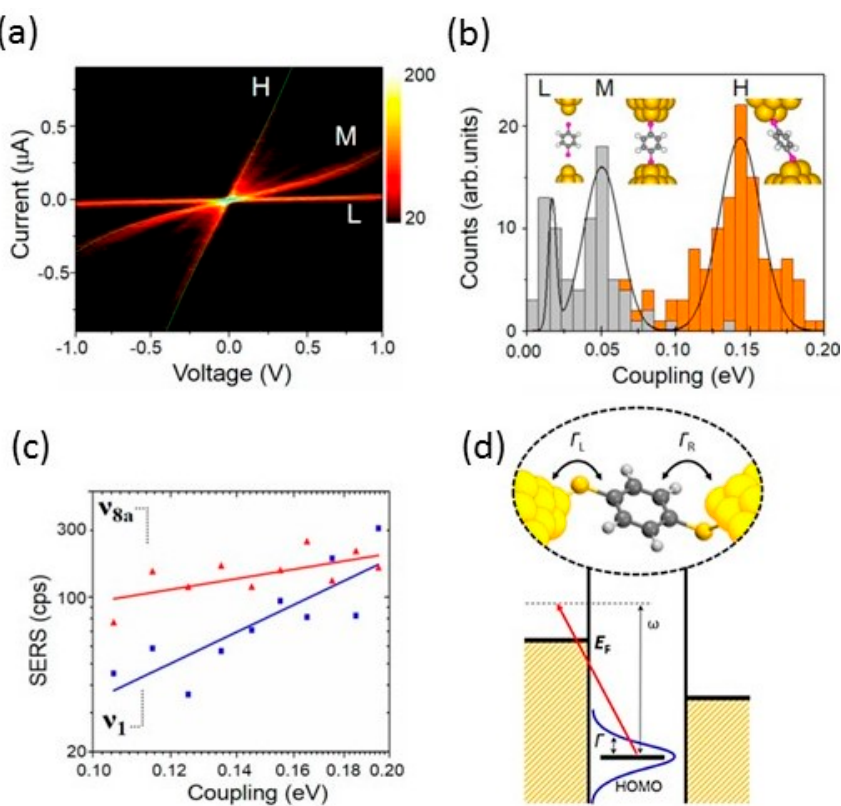
Figure 7. ( a ) Bidimensional I — V histogram summarizing the individual I — V response of single-molecule BDT junctions; ( b ) Statistical distribution of Γ . Orange counts correspond to ν 8a -active samples; ( c ) Correlation between the average intensity of the SERS signal ( ν 1 and ν 8 modes) as a function of Γ on a log—log plot; ( d ) Photo-induced charge transfer transition from HOMO to metal unoccupied state. The discrete molecular level is broadened by Γ [42].